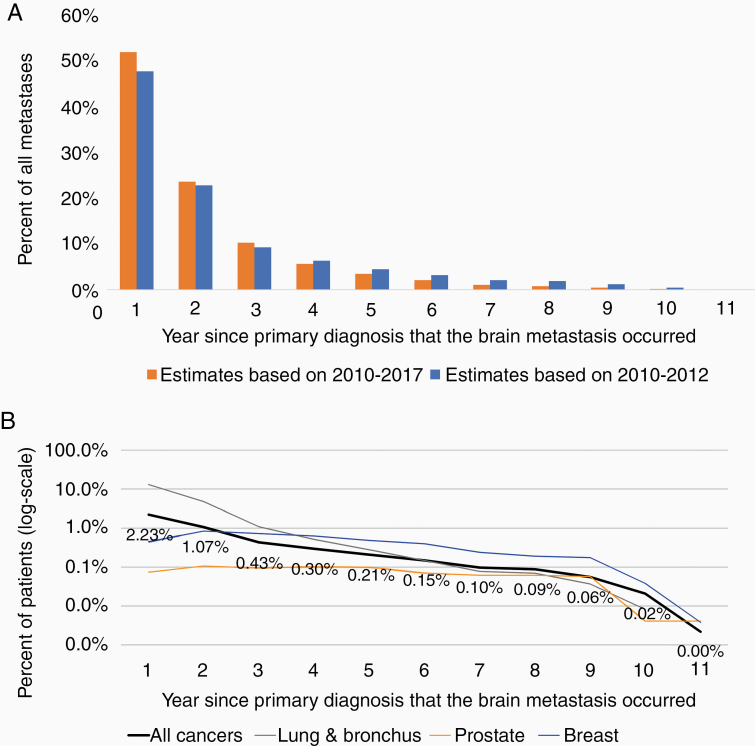
Rate of intracranial metastatic disease (IMD) over time by disease site. (A) Timing of occurrence of brain metastasis since original primary cancer diagnosis. (B) Timing of occurrence of brain metastasis since original primary cancer diagnosis by disease site (logarithmic scale). For a given year, the number of brain metastases is equal to 2.23% of the number of incident cancer diagnosis occurring the previous year plus 1.07% of cases diagnosed the previous year, and so on. Disease-site specific estimates can be derived from the percentages in Supplementary Table S8. To permit sufficient follow-up across disease sites to develop IMD, only primary cancers diagnosed between 2010 and 2012 were included.